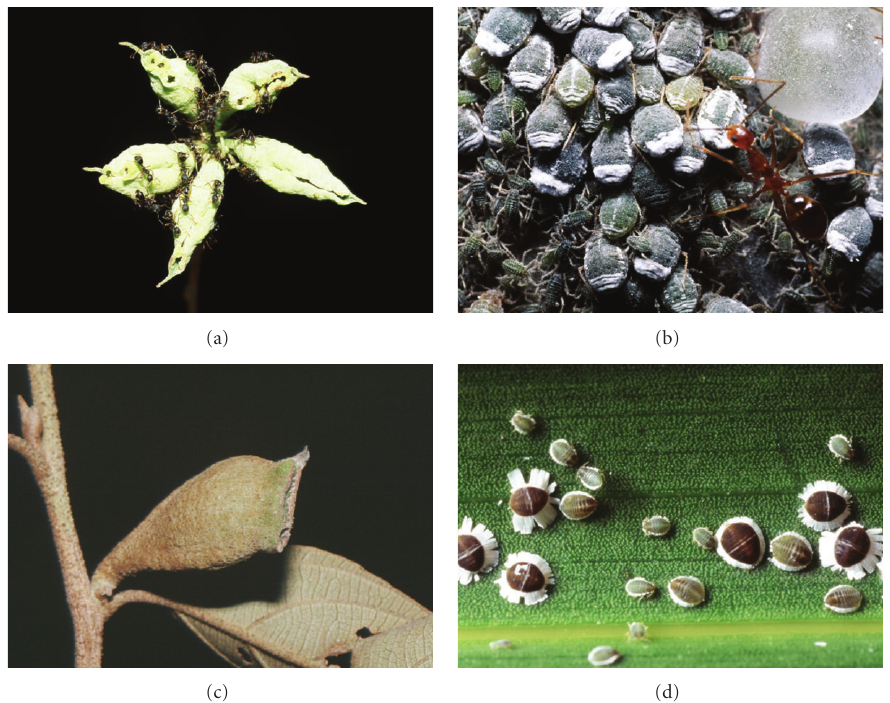
Figure 4: (a) A gall of Pseudoregma carolinensis on Styrax benzoides , with ants of Dolichoderus sp. (Chiang Mai, Thailand; 3 August 2000). (b) A colony of P. carolinensis on a bamboo shoot (Mae Sa, Chiang Mai Province, Thailand; 7 August 2000). (c) A gall of Cerataphis brasiliensis on Styrax benzoin (Tarutung, Sumatra; 3 March 1994). (d) A colony of C. brasiliensis on the palm Areca catechu (Bandar Baru, Sumatra; 28 August